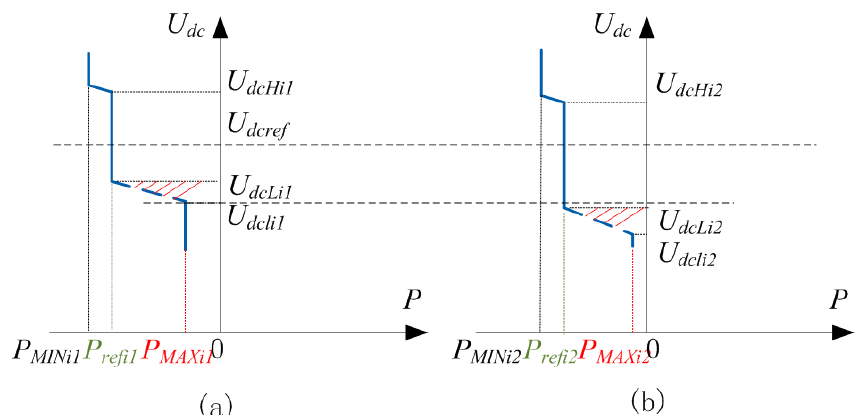
Figure 4. Control characteristics of voltage source converter (VSC) i1 priority mode. ( a ). U dc-P characteristics of VSC i1 . ( b ). U dc-P characteristics of VSC i2 .